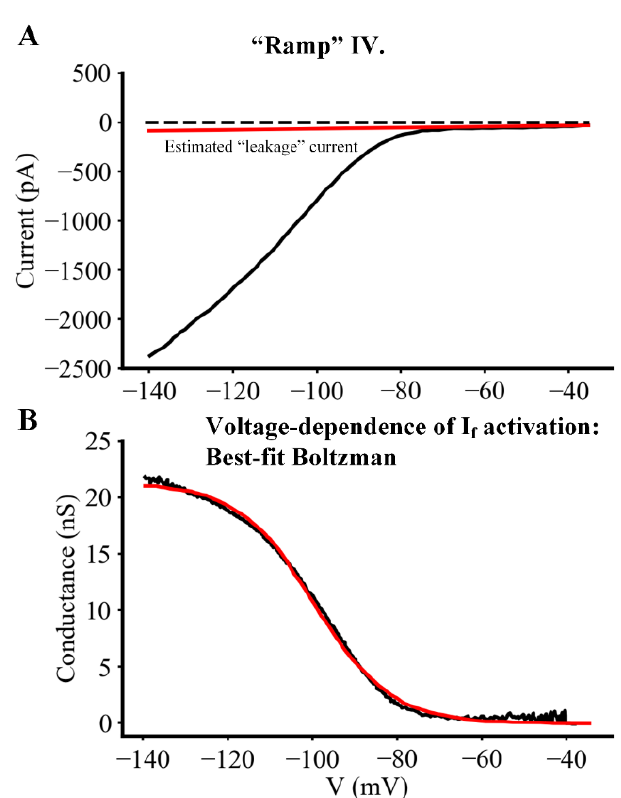
Figure 6; it consisted of a linear ‘ramp’ that first depolarized the membrane potential from the holding potential of − 60 mV to − 35 mV; and then ‘ramped’ back to − 135 mV over a period of 60 s. This was followed by an abrupt return to the holding potential of − 60 mV. Application of this voltage clamp protocol resulted in a continuous current change such as the one shown in the black trace in Figure 7A. This ramp command was repeated four times at a rate of one per five minutes and the resulting current change records were averaged, yielding data sets such as the one shown in Figure 7A.